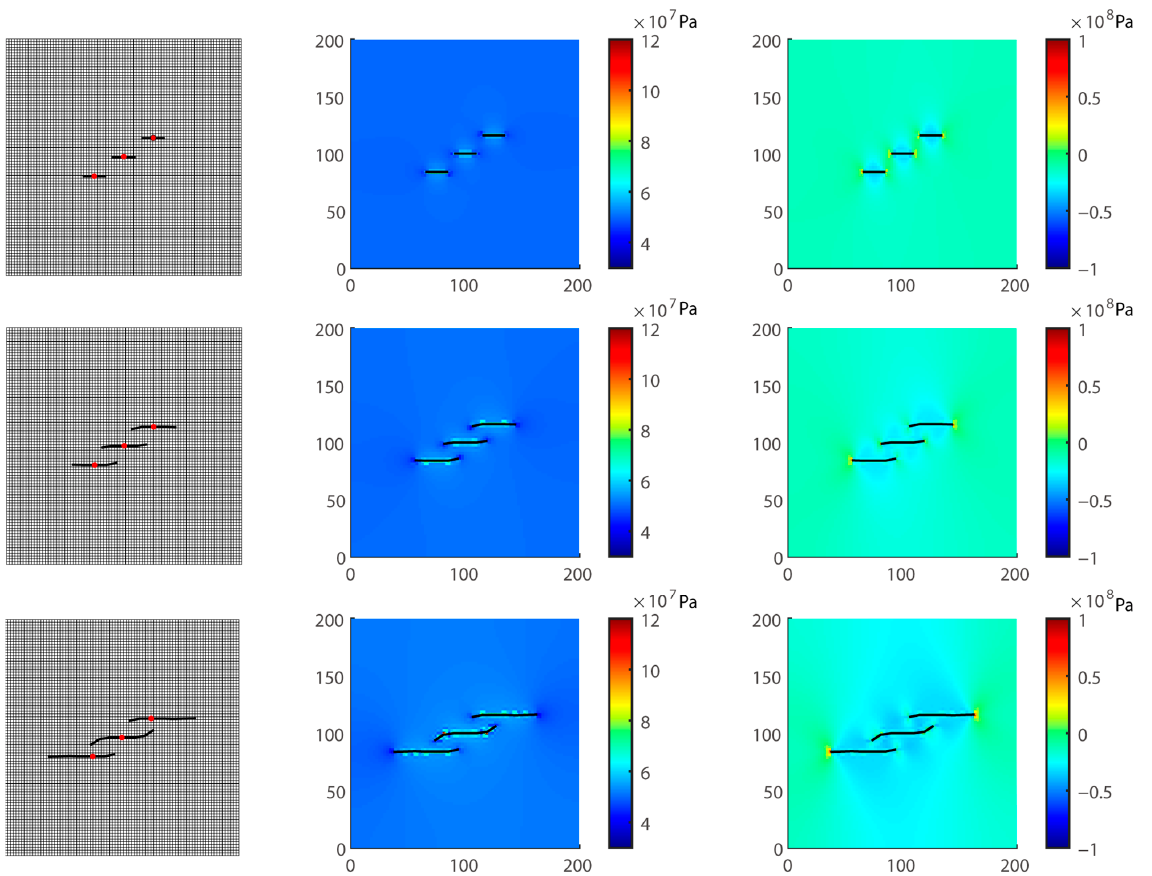
Figure 11. Sequential growth of En échelon fractures: trajectory, pressure, and effective stress com- σ′ ponent y after 20 s, 70 s, and 170 s.